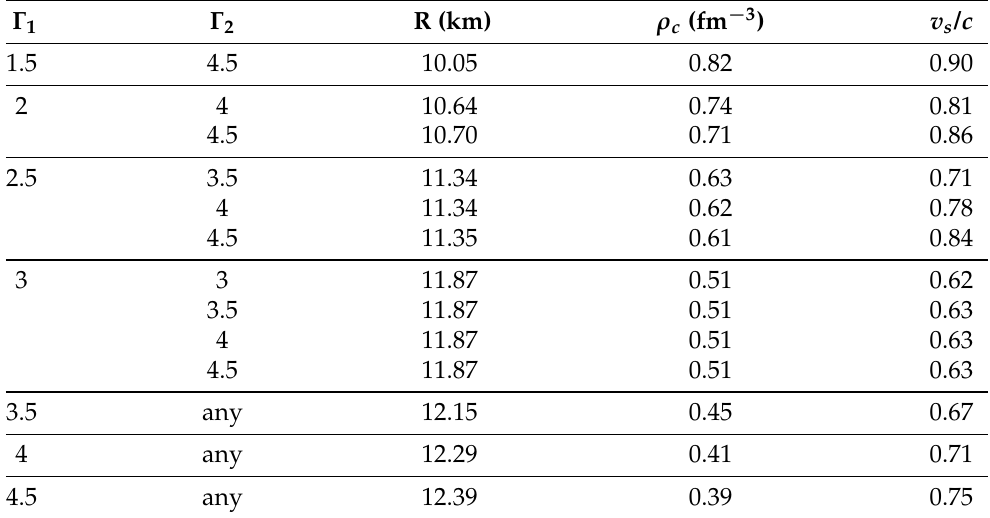
Figure 5. Symmetry energy as a function of density, order by order. Table 3. Radius, R , central density, ρ c , and speed of sound at central density, v s / c (in units of the speed of light), for M = 1.4 M (cid:12) at N 3 LO and Λ = 450 MeV. The shown values of Γ 1 and Γ 2 are the combinations of polytropic indices consistent with both the maximum mass and the causality constraints up to the relevant densities. When the star’s central density is below the second matching density, there is no dependence on Γ 2